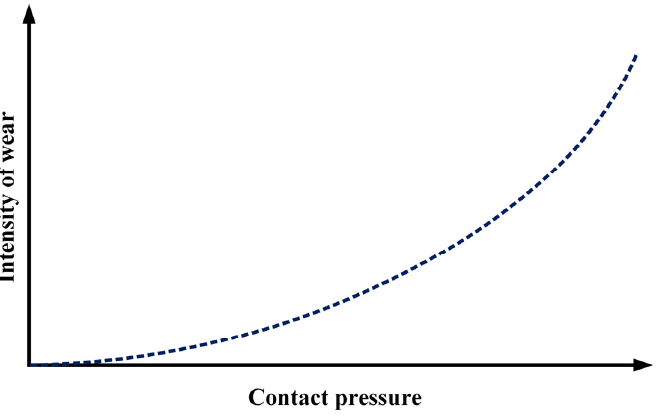
Figure 1. Correlation between contact pressure and intensity of wear [25].